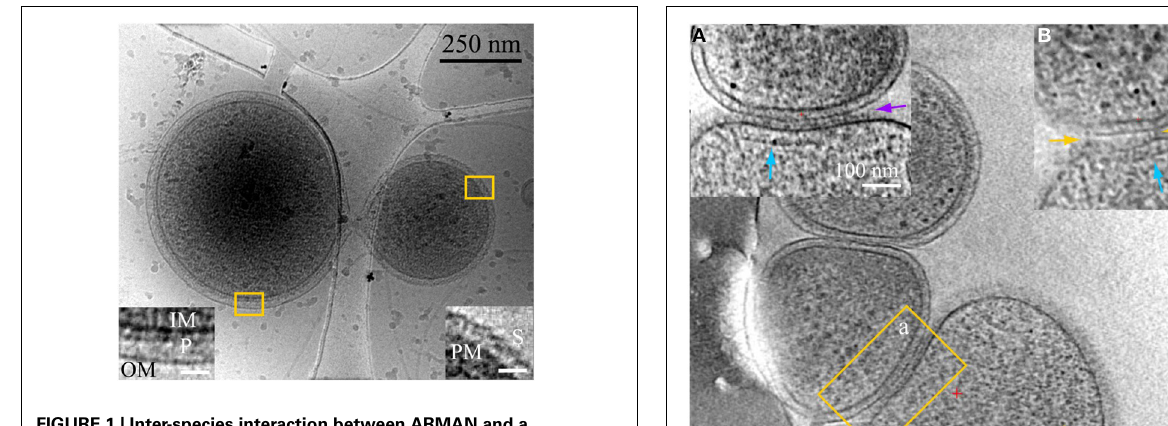
FIGURE 1 | Inter-species interaction between ARMAN and a Thermoplasmatal cell through a cytoplasmic bridge or synapse-like connetion. 2D cryo-TEM projection showing a “synapse-like” structural connection between an ARMAN cell, left (gram negative-like cell wall), and a Thermoplasma “bud” with an S-layer-like outer surface (see also Figure S3; Huber and Stetter, 2006). Insets show a magnified view of the regions within the yellow box, left and right respectively. Left inset: IM, OM, P are inner membrane, outer membrane, and periplasmic space respectively. Right inset: PM and S are the plasma membrane and S-layer respectively. The white scale bars are 25nm.